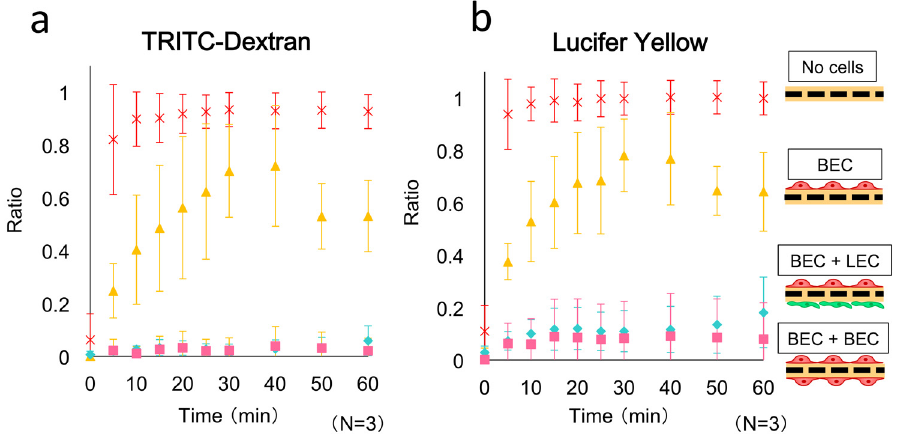
Fig 3. Permeability measured using the microfluidic system lacking or containing BECs and LECs. No cells (x), BEC monolayer (yellow triangles), BEC-LEC coculture (blue diamonds), and BEC-BEC coculture (pink squares). The values are presented as means ± SD. The fluorescent tracers used were (a) TRITC- dextran and (b) Lucifer Yellow. The statistical significance of the differences between the values obtained at 60 min was evaluated using t tests: (a) P < 0.005, between No cells and BEC monolayer; P < 0.001, between BEC monolayer and BEC-LEC coculture; and P < 0.32, between BEC-LEC coculture and BEC-BEC coculture. (b) P < 0.001, between No cells and BEC monolayer; P < 0.001, between BEC monolayer and BEC-LEC coculture; and P < 0.45, between BEC-LEC coculture and BEC-BEC coculture. Each data point was obtained from three devices (n =